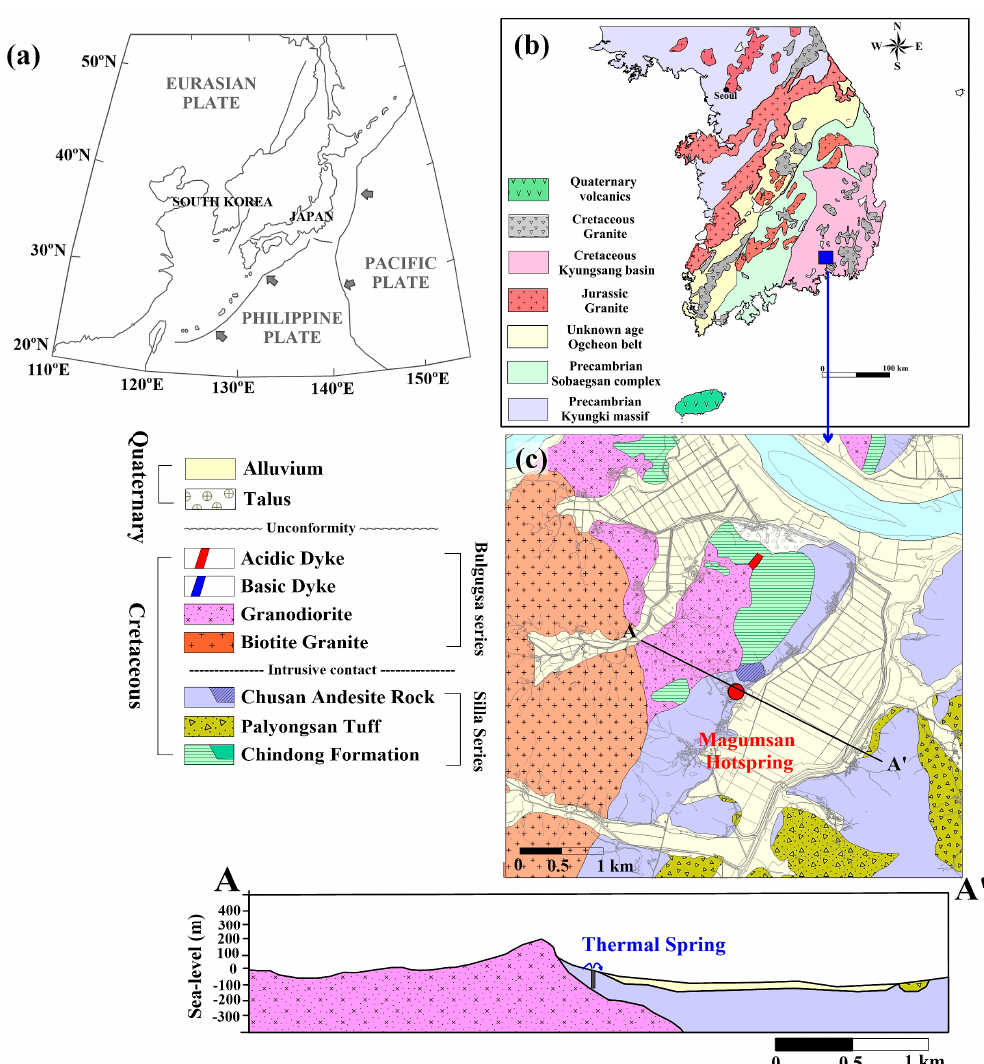
Figure 1. Location and geological maps. ( a ) Tectonic framework of northeast Asia; ( b ) major geological units of South Korea; ( c ) geology of the Magumsan area, including a cross-section (A–A ′ ) [16].